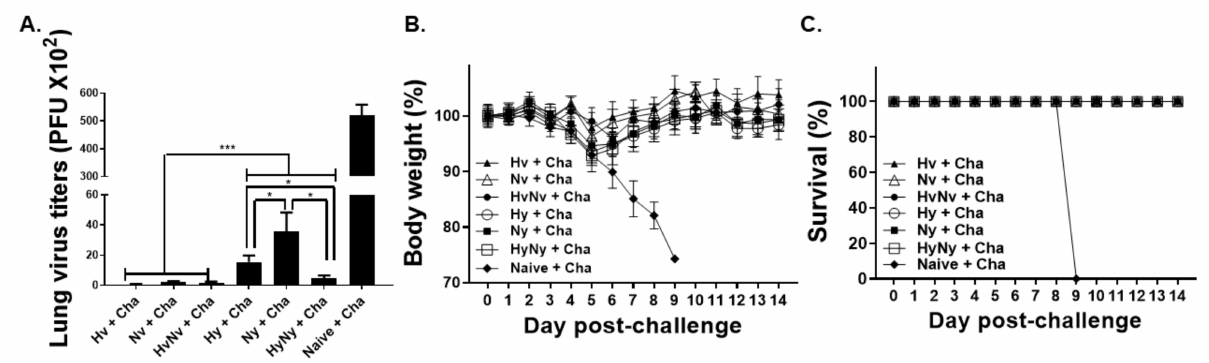
Figure 7. Lung virus loads, body weight changes, and survival after lethal influenza B virus challenge. BALB/c mice were challenged with a lethal dose of influenza B virus and vaccine efficacy was evaluated by measuring the lung virus titer ( A ), bodyweight changes ( B ), and survival ( C ). Naïve+Cha refers to those naïve mice who were challenge infected with a lethal dose of influenza virus. Data are expressed as mean ± SD with asterisks denoting statistical significance between groups (* p < 0.05, *** p <